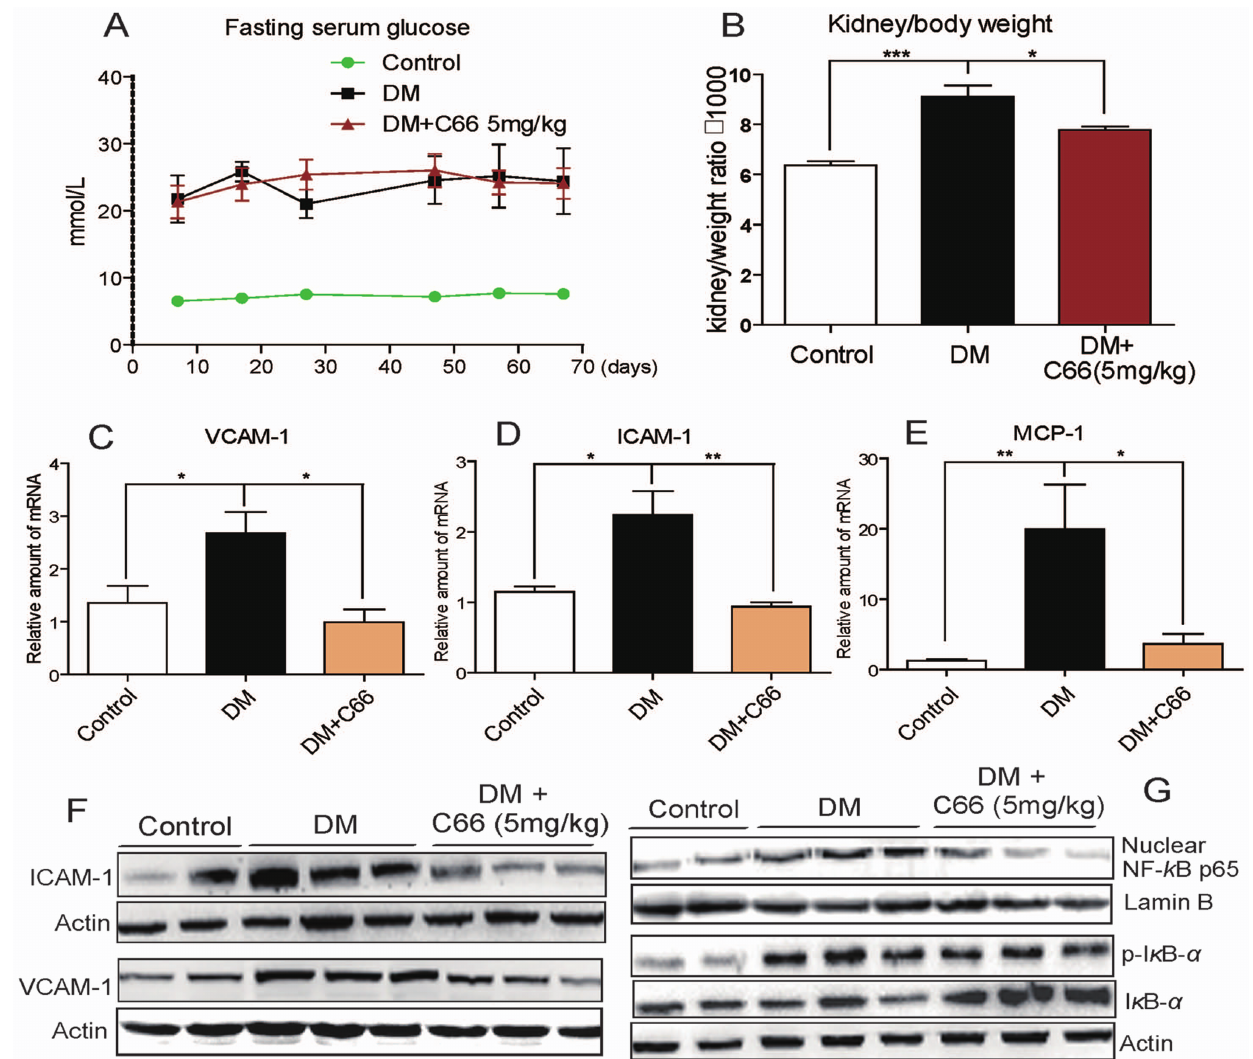
Figure 5. C66 treatment decreased renal expression of adhesion molecules, chemokines and NF- k B activation in diabetic mice. A) Diabetes induced increased blood glucose levels were not affected by C66 treatment. B) Kidney/body weight ratios in diabetic mice were improved by C66 treatment. C–E). Increased renal mRNA expressions of VCAM-1 (C), ICAM-1 (D), and MCP-1 (E) in diabetic mice were prevented by C66 treatment. RNA levels (mean 6 SD) are expressed as a ratio of b -actin n=6/group (* p , 0.05, ** p , 0.01). F) Western blot analysis of extracted proteins from the nuclear and cytoplasmic fractions showing diabetes-induced increased expressions of VCAM-1 and ICAM-1, and NF- k B activation were prevented by C66. (DM=diabetic